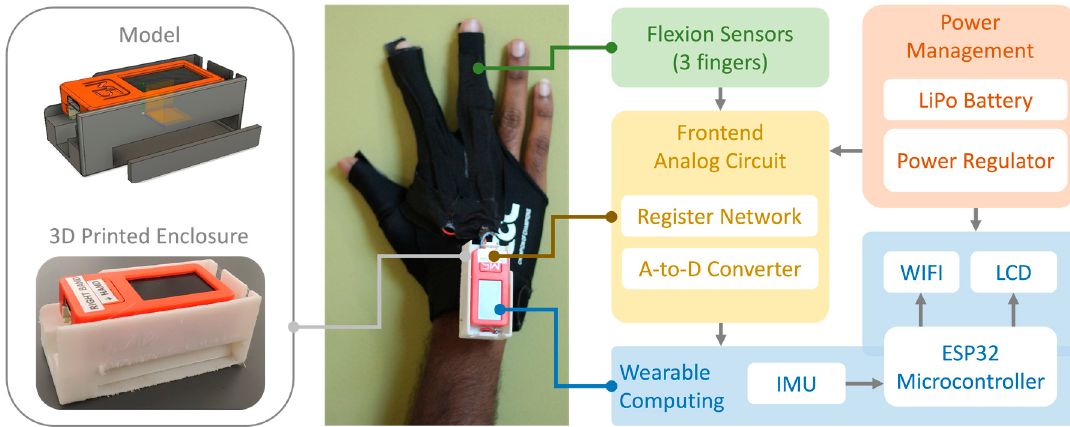
Figure 2. A functional block diagram of the iTex glove.